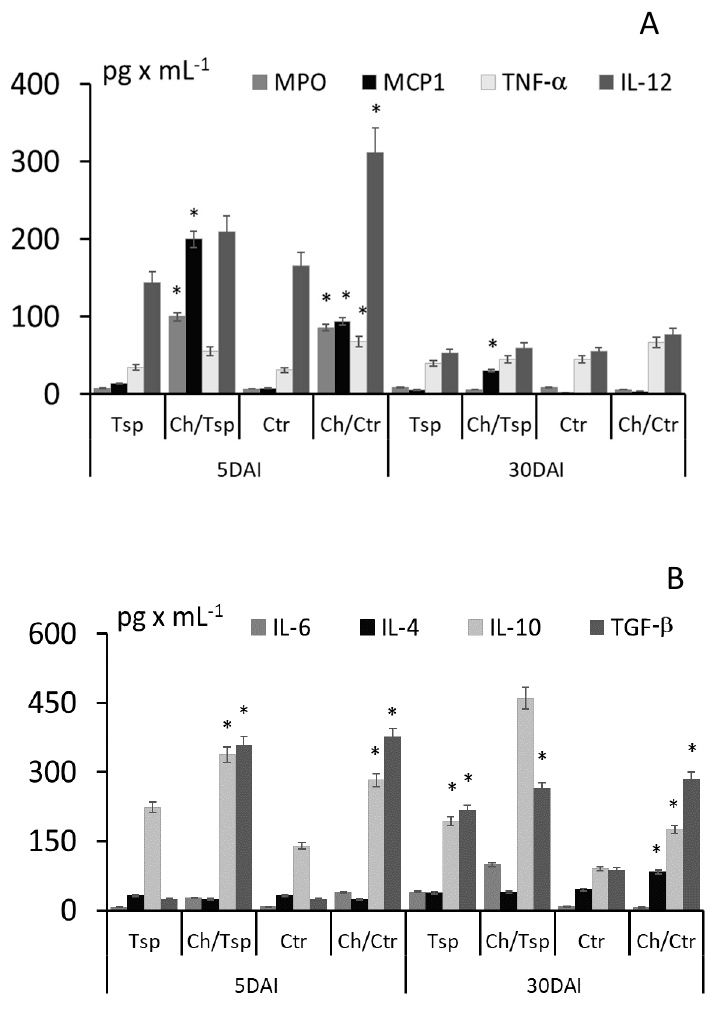
Figure 3. Myeloperoxidase (MPO) and cytokine response A : MCP-1, TNF- α ; and B : IL-6, IL-4, IL-10, TGF- β in the peritoneal fluid of mice injected with chitosan and infected with T. spiralis : 5 and 30 DAI. (*) p < 0.05, all groups vs. control, uninfected. In the first period of treatment, chitosan supported inflammation and the response became a regulatory milieu.